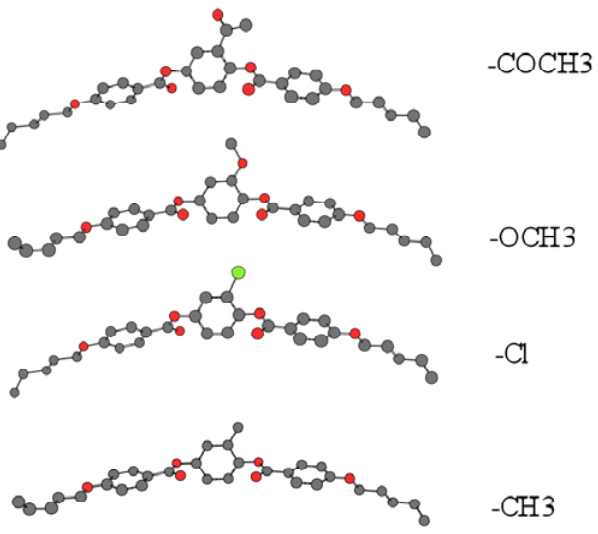
Figure 12. Lateral substitution in the